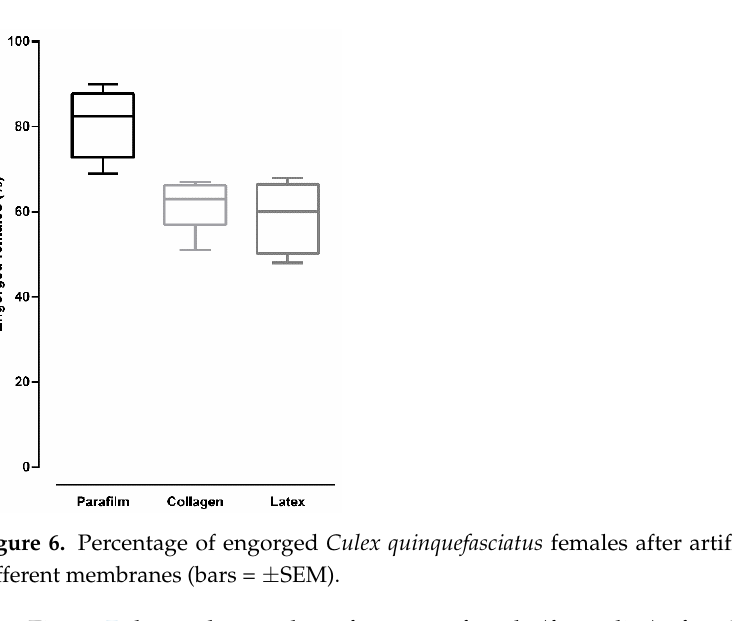
Figure 8. Egg hatchability after Culex quinquefasciatus females were artificially blood-fed through different membranes (bars = ±SEM). Figure 9 shows the weight-increase ratio after Culex quinquefasciatus females were artificially fed on blood using different membranes. Overall, there was a significant difference in weight-increase ratio according to the used membrane type (ANOVA: F (2, 24) = 22.99, p < 0.0001). Females fed on Parafilm ® and collagen showed an increase that was more than double the original weight before feeding. Tukey’s multiple-comparison test revealed no significant statistical difference between Parafilm ® and collagen ( p = 0.154). Females fed on latex showed a weight increase that was less than double the original weight before feeding. Tukey’s multiple-comparison test revealed a significant statistical difference between Parafilm ® and latex, and between collagen and latex ( p < 0.05 for both comparisons).